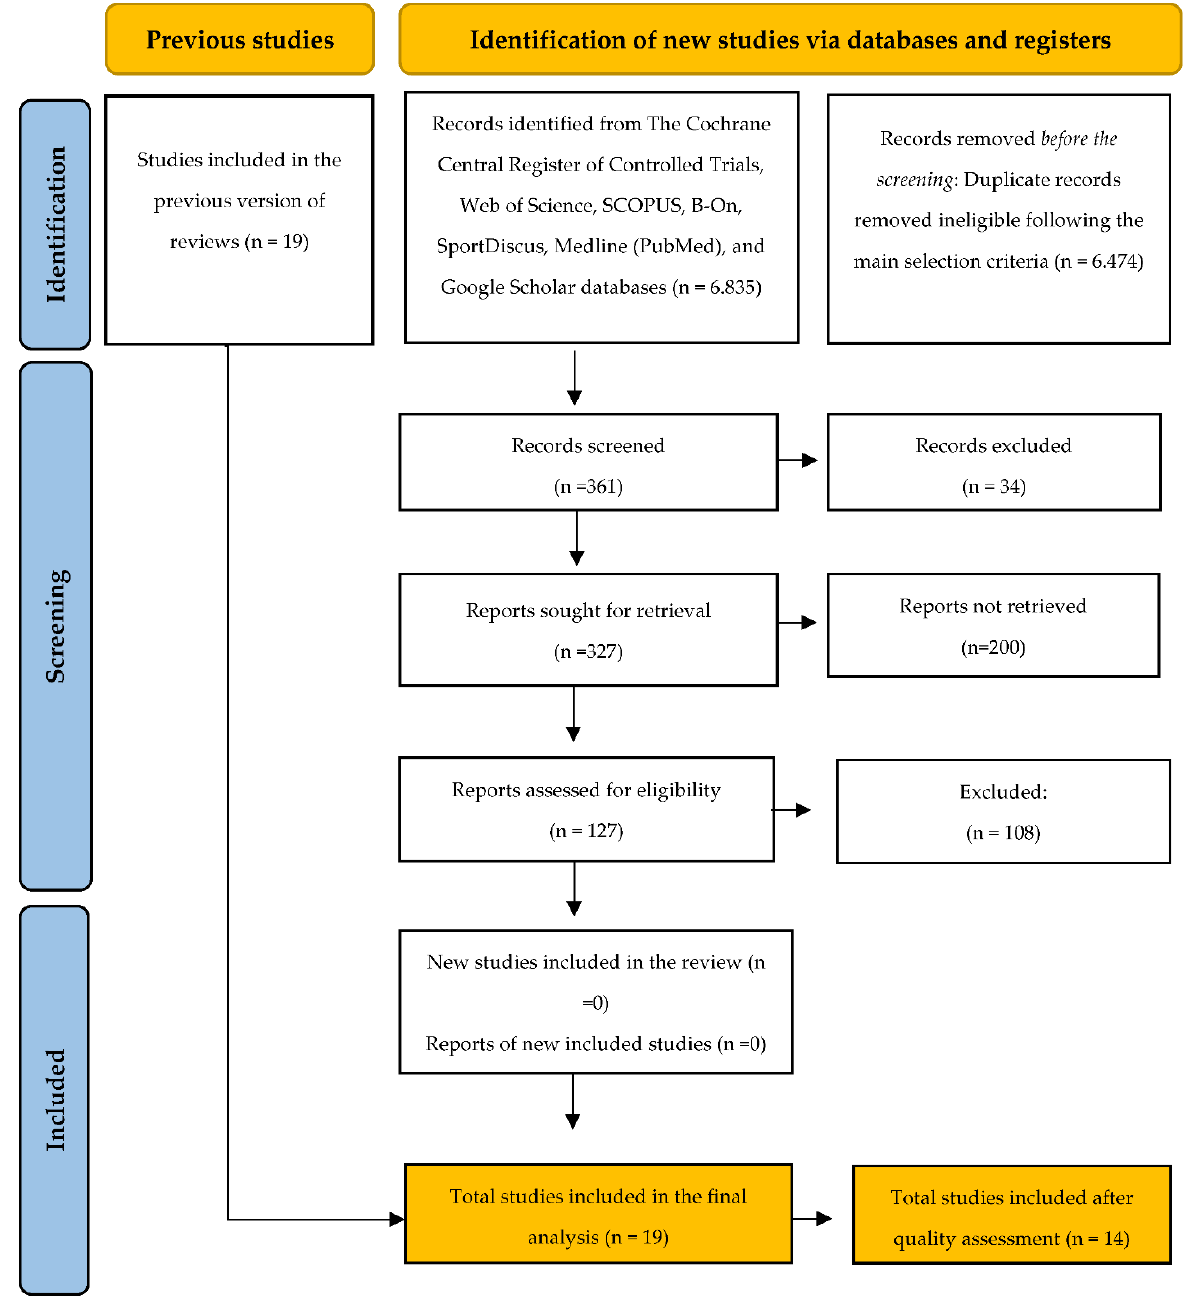
Figure 1. PRISMA of each stage of the study selection.